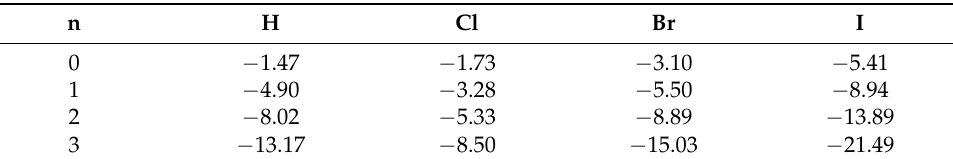
Table 6. BSSE-corrected MP2// ω B97X-D/aug-cc-pVTZ interaction energies, ∆ E(kcal/mol), for